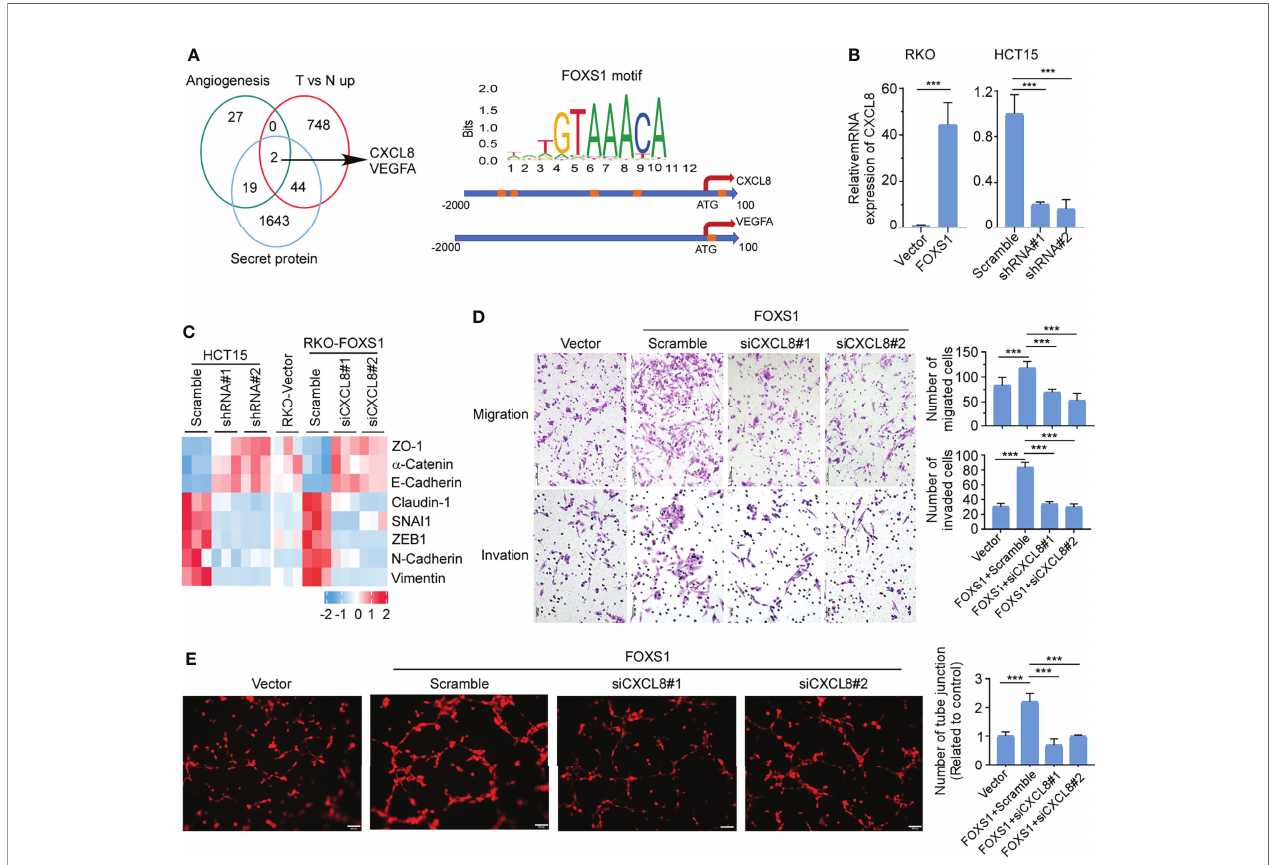
FIGURE 5 | FOXS1 promotes EMT and angiogenesis by upregulating CXCL8. (A) Venn diagram analysis across three groups of genes (left). (i) Angiogenesis signature genes (n = 48); (ii) differentially expressed tumor versus normal in GSE18105 (n = 794); (iii) secreted protein genes (n = 1,708). The FOXS1 motif (orange boxes) was searched on the promoter loci of the CXCL8 gene and VEGFA gene in the JASPAR database. (B) Real-time PCR analysis of CXCL8 expression in CRC cell lines. (C) Real-time PCR analysis of the expression of epithelial – mesenchymal transition markers in CRC cell lines. (D) Transwell migration assay and transwell invasion assay were performed to determine the effects of CXCL8 depletion on the migratory and invasive abilities of FOXS1-overexpressed CRC cells. Scale bars: 50 µm. (E) HUVEC tube formation after stimulation with the indicated conditional medium from FOXS1-overexpressed CRC cells with or without CXCL8 depletion. Scale bar: 100 µm. *** p <